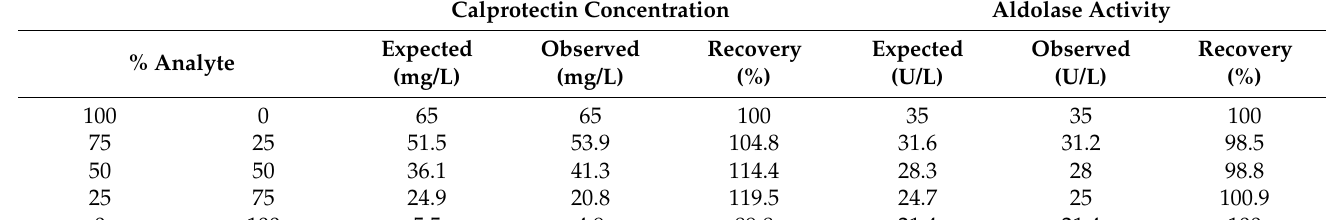
Table 2. Recovery of calprotectin and aldolase measurements in horse saliva.